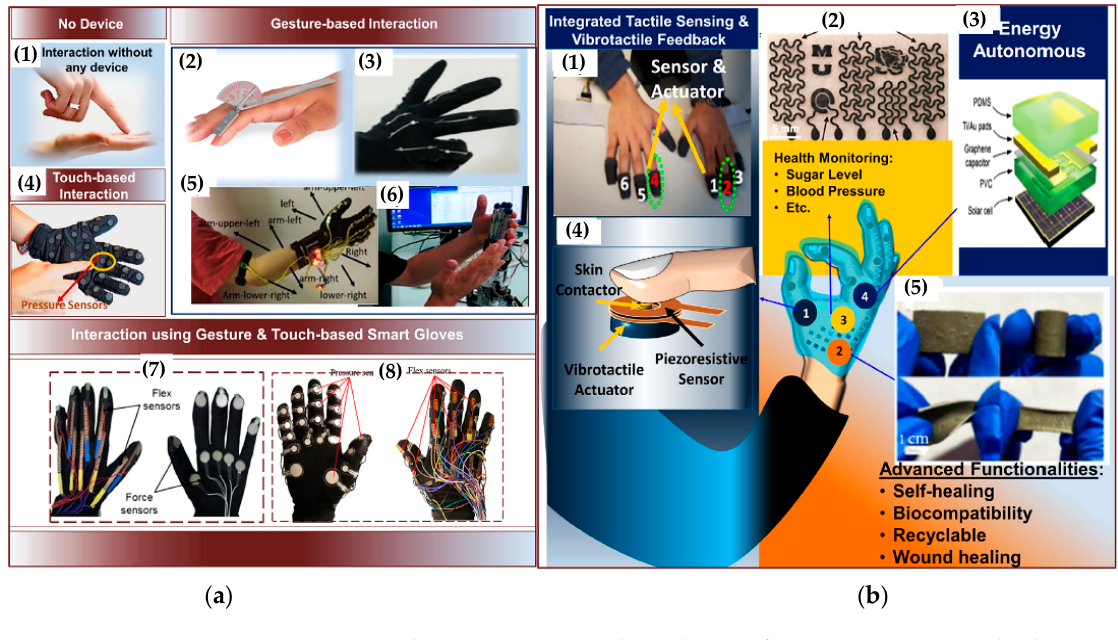
Figure 13. Manual user interaction without the use of any equipment ( a1 ). The doctor assesses the finger angle with goniometers for therapeutic purposes ( a2 ). A smart glove that recognizes gestures and uses a highly stretchy, polymer-enhanced strain sensor ( a3 ) [111]. An interactive smart glove that uses touch and the Lorm alphabet to facilitate communication for the deafblind ( a4 ) [112]. An IMMU-assisted smart glove for capturing and identifying 3D human gestures ( a5 ) [110]. Gesture-based methods for deafblind remote communication utilizing PARLOMA, a revolutionary human–robot interaction system ( a6 ). A soft intelligent glove for hand rehabilitation that combines touch and gesture methods ( a7 ). For badminton, a sensory glove is employed to describe delicate hand motions ( a8 ). Tactile feedback and integrated haptic sensing ( b1 ). Gas-permeable, multipurpose electronic- skin electronic realized by laser-induced porous graphene and a spongy layer made of elastomer with a sugar template ( b2 ). An energy-autonomous electronic skin ( b3 ). A smart glove designed as an assistive device integrating touch sensors and actuators for persons who are deafblind ( b4 ). A material for electronic skin applications that is self-healing and self-powered ( b5 ) [93].